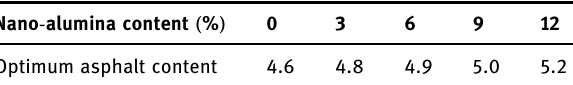
Table 3: Optimum asphalt content of asphalt mixture with di ff erent nano - alumina contents Nano - alumina content ( %